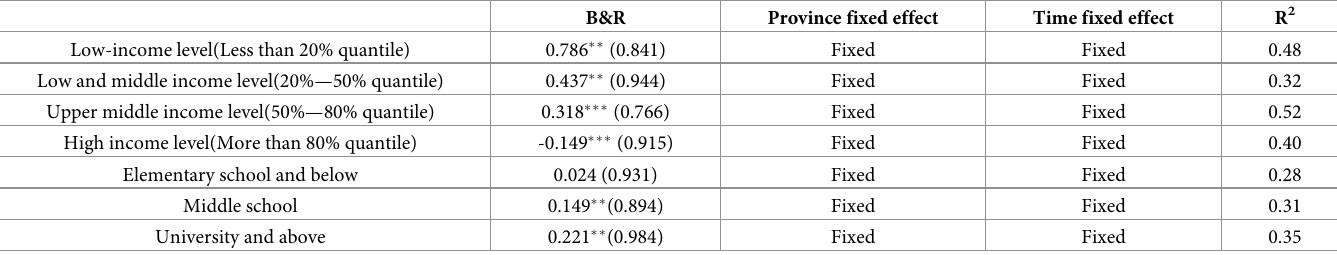
Table 4. Quantile heterogeneity results of the effects of B&V on rural residents’ income.